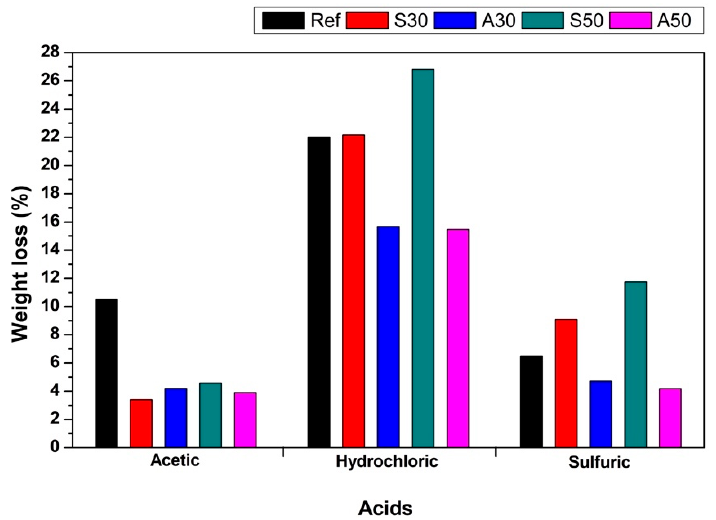
Figure 8. Acid attack susceptibility test results at five months.